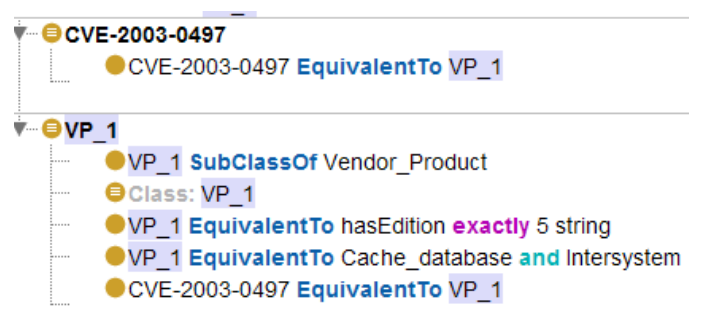
Figure 5. An example of ontological representation of